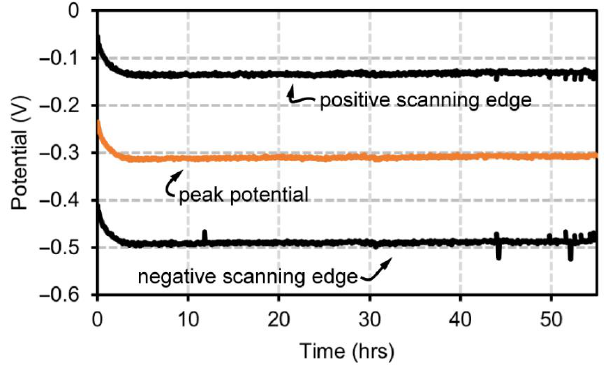
Figure 4. Voltage window analysis using peak tracking. Scanning edges, and peak potentials tracked with peak tracking code for over 50